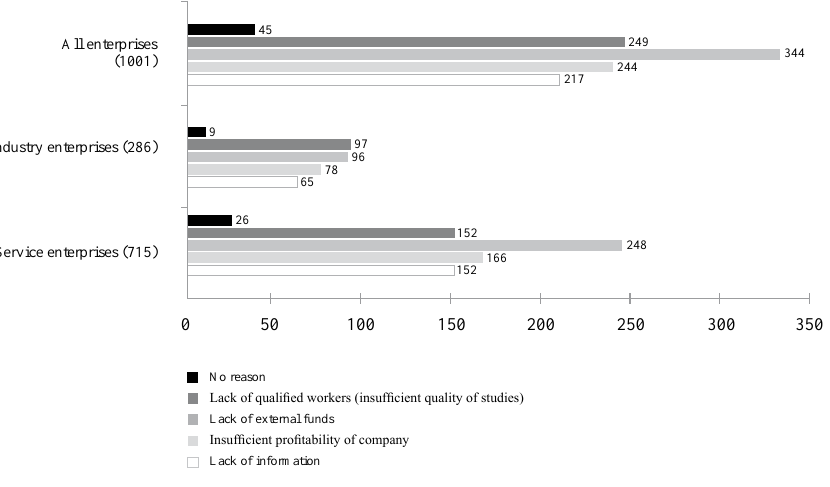
fig. 10. Factors retarding technology transfer